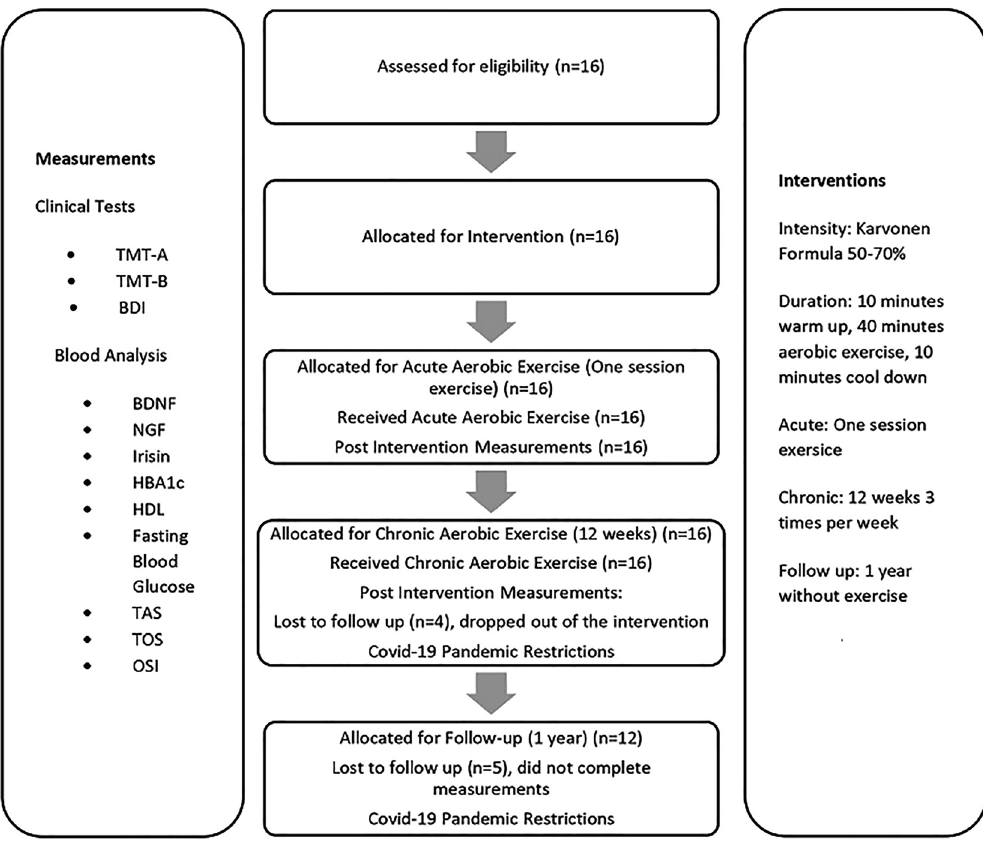
Figure 1: The description of the logistics of the study. TMT, trail making test; BDI, Beck depression inventory; HbA 1c , hemoglobin A1c; HDL, high-density lipoprotein cholesterol; TAS, total antioxidant status; TOS, total oxidant status; OSI, oxidative stress index; BDNF, brain-derived neurotrophic factor; NGF, nerve growth